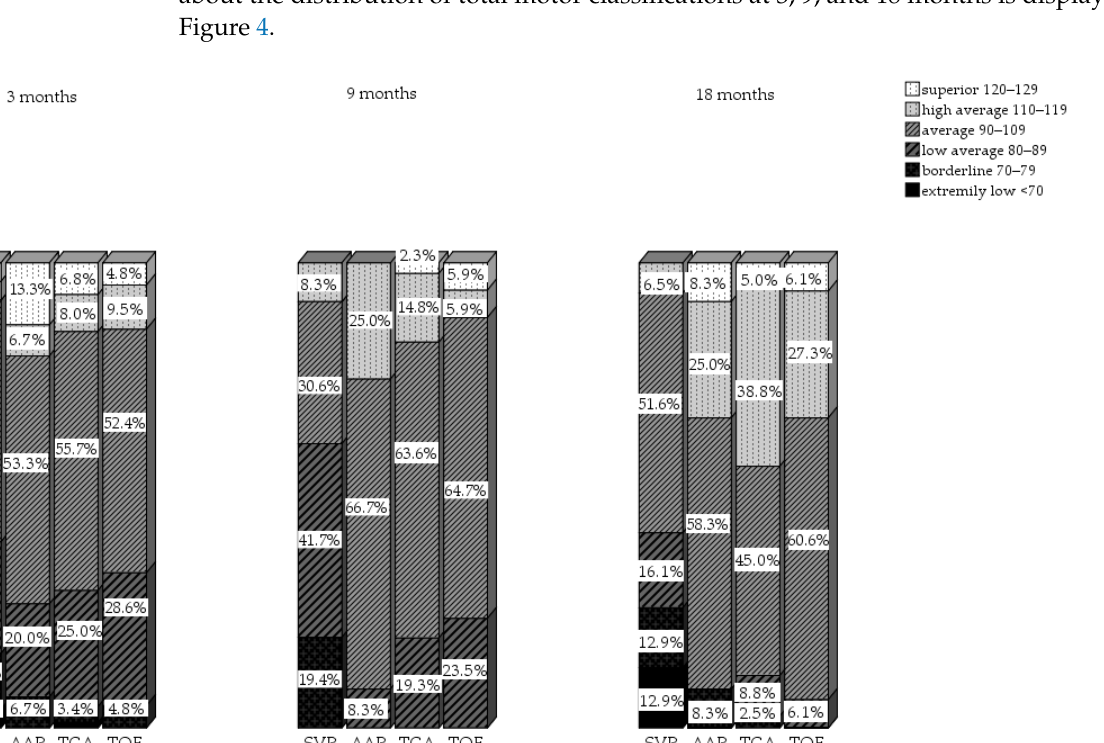
Figure 4. Bayley-III NL total motor development at 3, 9, 18 months specified per diagnosis group. SVP = single-ventricle physiology, TGA = transposition of great arteries, AAP = aortic arch pathol- ogy, TOF = tetralogy of Fallot.